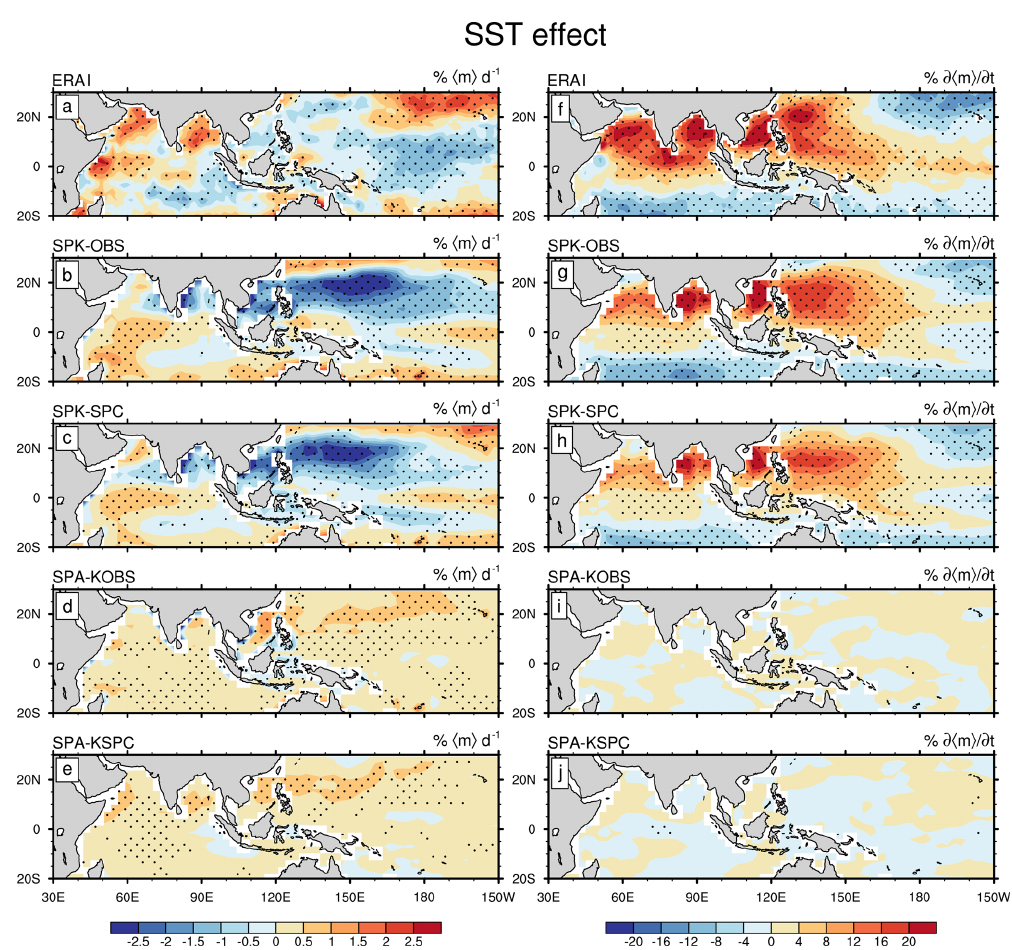
Figure 8. SST effect on (a–e) (cid:104) m (cid:105) and (f–j) ∂ (cid:104) m (cid:105) /∂t through the modification of surface turbulent fluxes for (a, f) ERAI, (b, g) SPK-OBS, (c, h) SPK-SPC, (d, i) SPA-KOBS, and (e, j) SPA-KSPC. Stippling indicates regression coefficient is significant at the 95% confidence